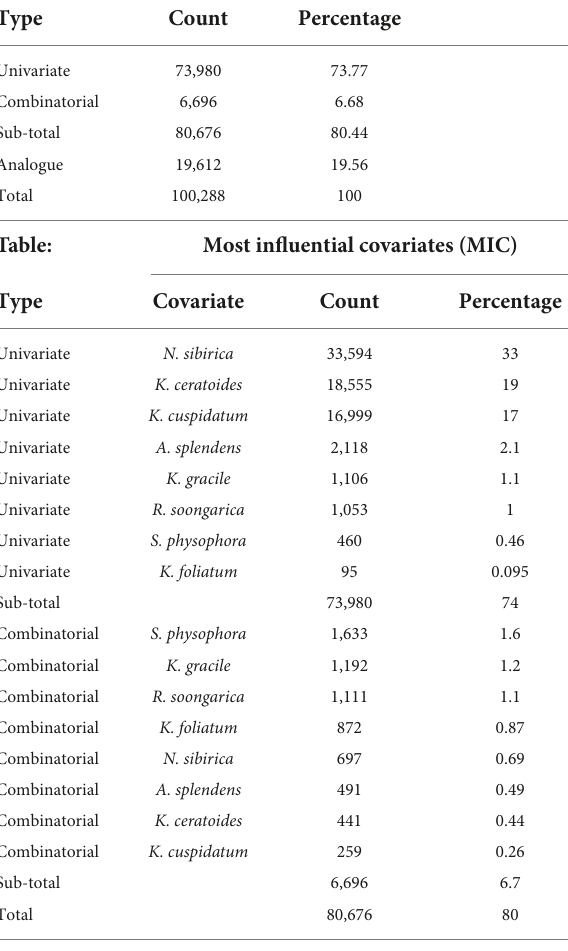
TABLE 2 The extrapolation values and the most influential covariates. Table: Extrapolation